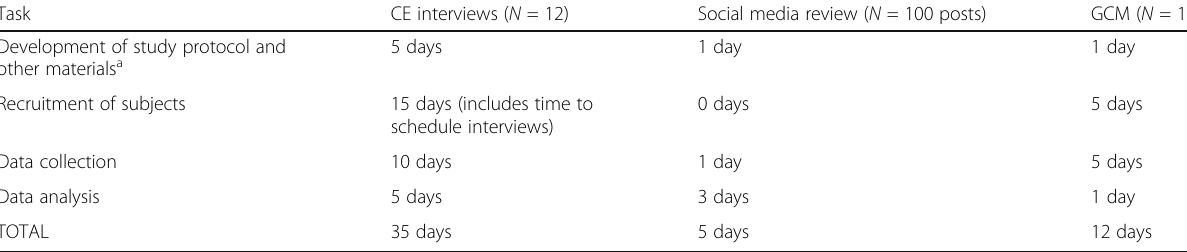
Table 5 Comparison of the time invested for each method evaluated Task CE interviews ( N =